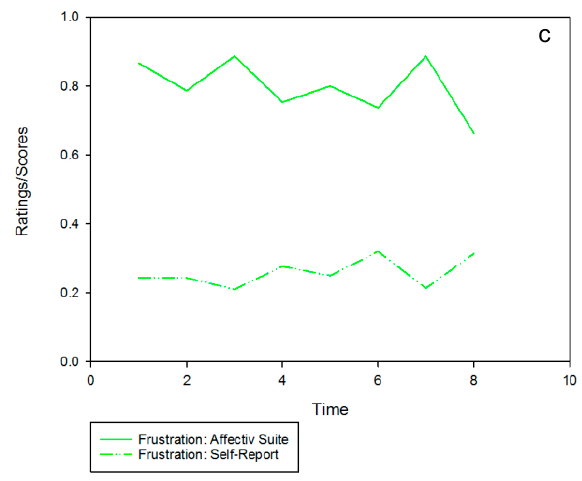
Figure 5. Affectiv and self-report outputs (( a ) “excitement”, ( b ) “engagement”, and ( c ) “frustration”) during the urban green to urban busy walking route. Time points 1–4 refer to the first section of the walk (urban green) and time points 5–8 refer to the second section (urban busy).